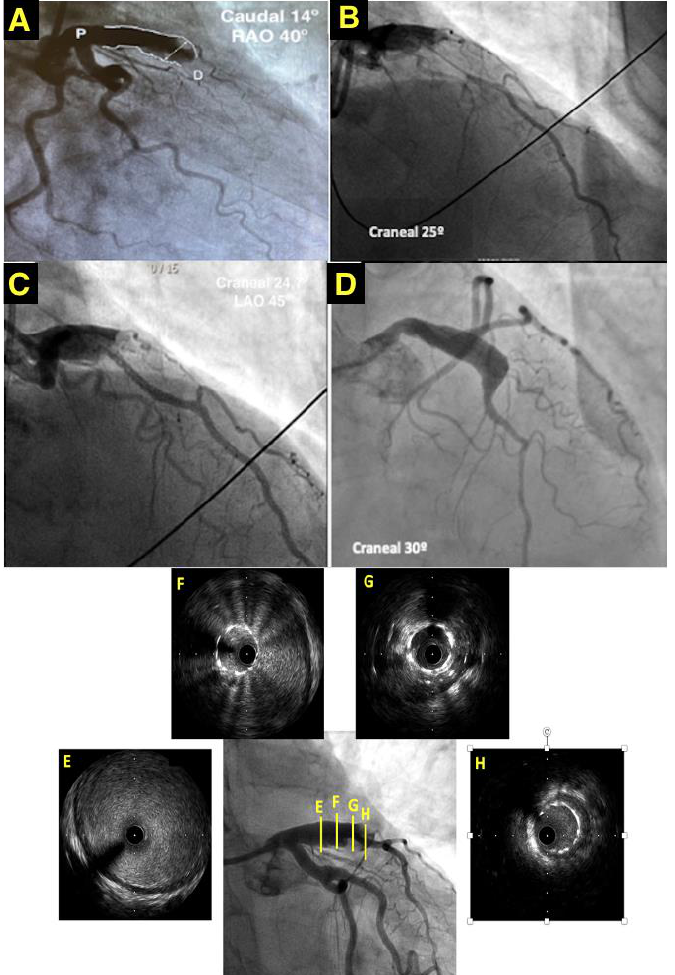
Figure 1. ( A ) CY showing a CAA with a maximum diameter of 8.49 mm (white double arrow). ( B ) CY displaying simultaneous contrast infusion from the microcatheter and support catheter. ( C ) CY showing aneurysm after stent implantation. ( D ) CY displaying the “funnel” shape of the distal segment of the aneurysm after the post-dilatation. ( E – H ) Coronary IVUS showing the stent apposition along the CAA in the ADA showing the stent “floating” in the aneurysm surrounded by thrombus. RAO: Right anterior oblique. LAO: Left anterior oblique.